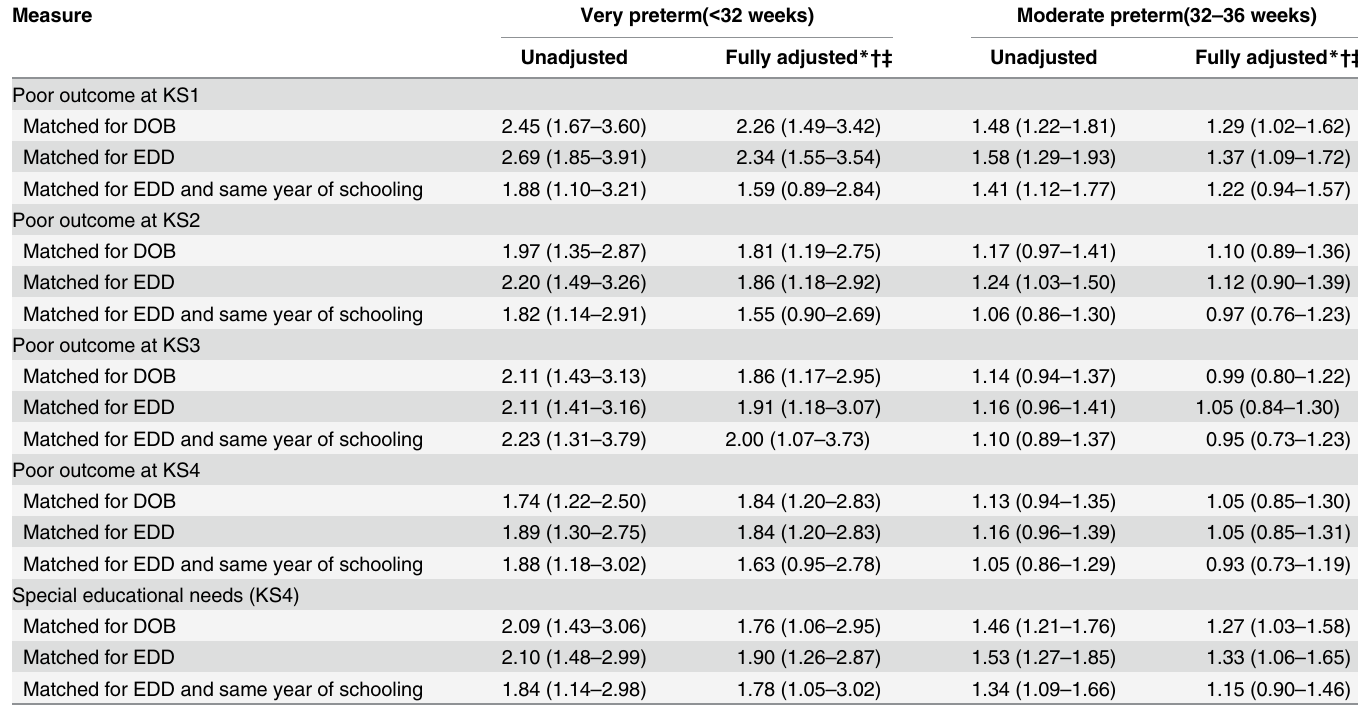
Table 4. Association between being born very or moderate preterm and school